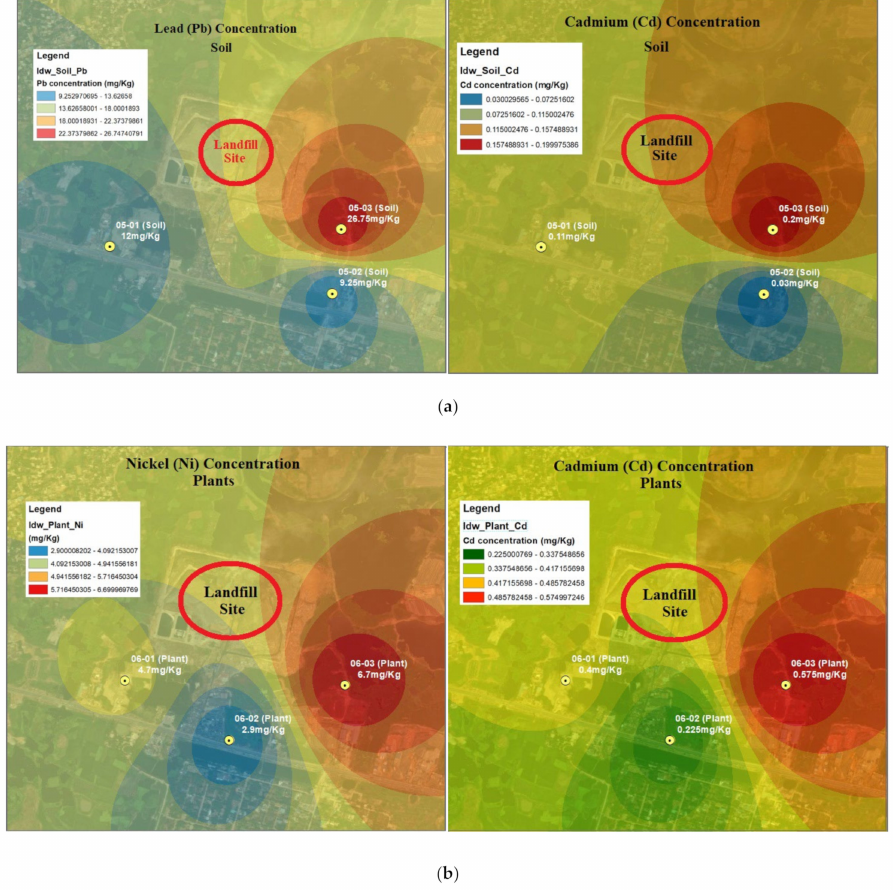
Figure 6. IWD of ( a ) Pb and Cd concentration in soil samples and ( b ) Ni and Cd concentration in plant